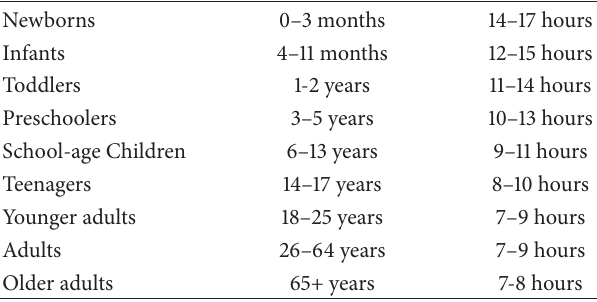
Table 2: The National Sleep Foundation’s recommended amount of sleep per age group